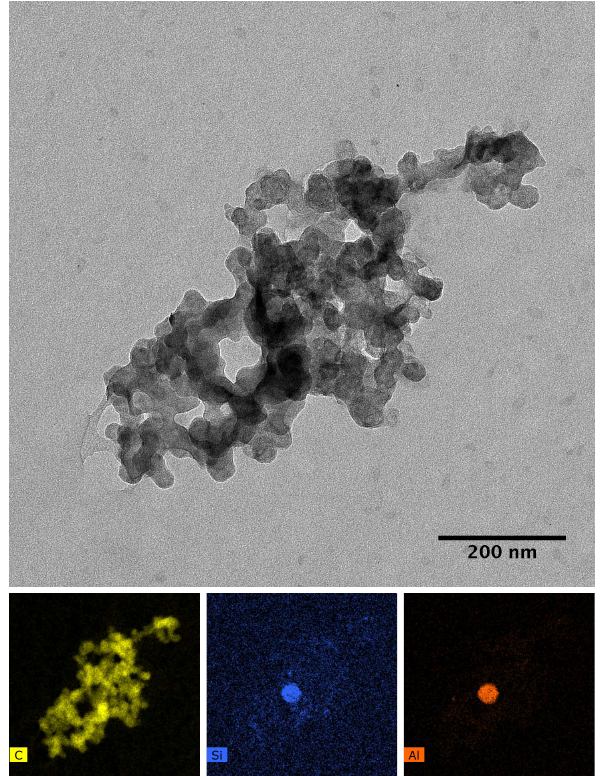
Figure 5. TEM image of a particle from Darwin rain sample col- lected 11 April 2014, with accompanying STEM EDS maps of car- bon, silicon, and aluminum. Element maps are from the same field of view as the TEM